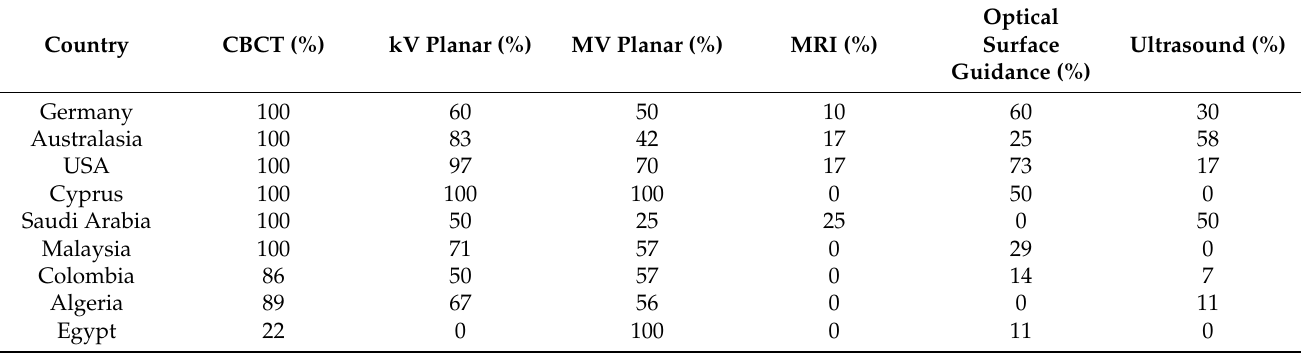
Table 2. Percentages of radiotherapy centres in each country using different imaging modalities to check patient position during treatment